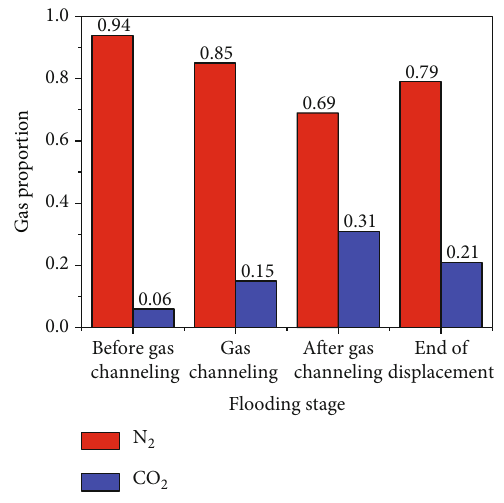
Figure 7: Comparison of gas components produced in di ff erent displacement